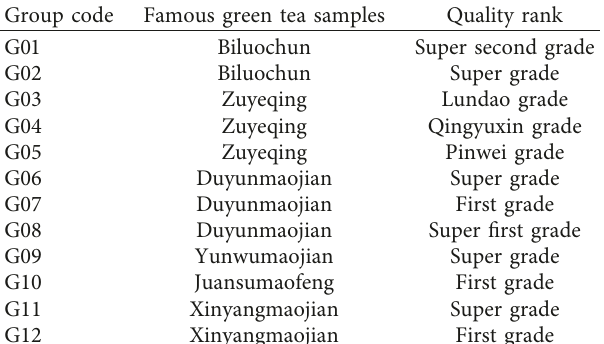
Table 1: The detailed information of green teas. Group code Famous green tea